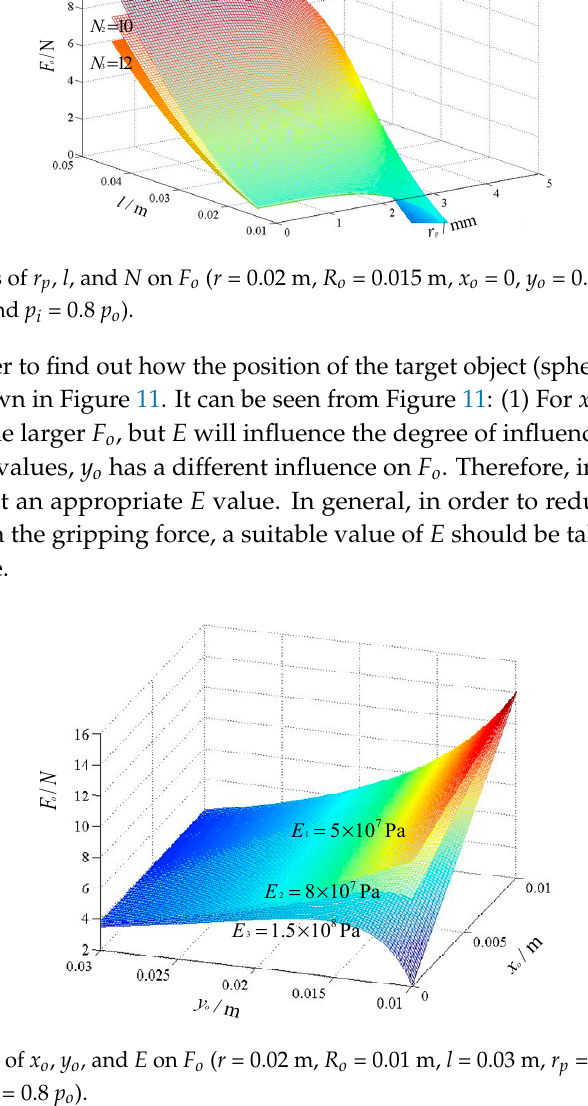
F Figure 12. The instability of pin. The pin can be simplified as a model of an elongated compression rod with one end free and the other end fixed. The critical load [27] under this model is: 2 2 4 cr